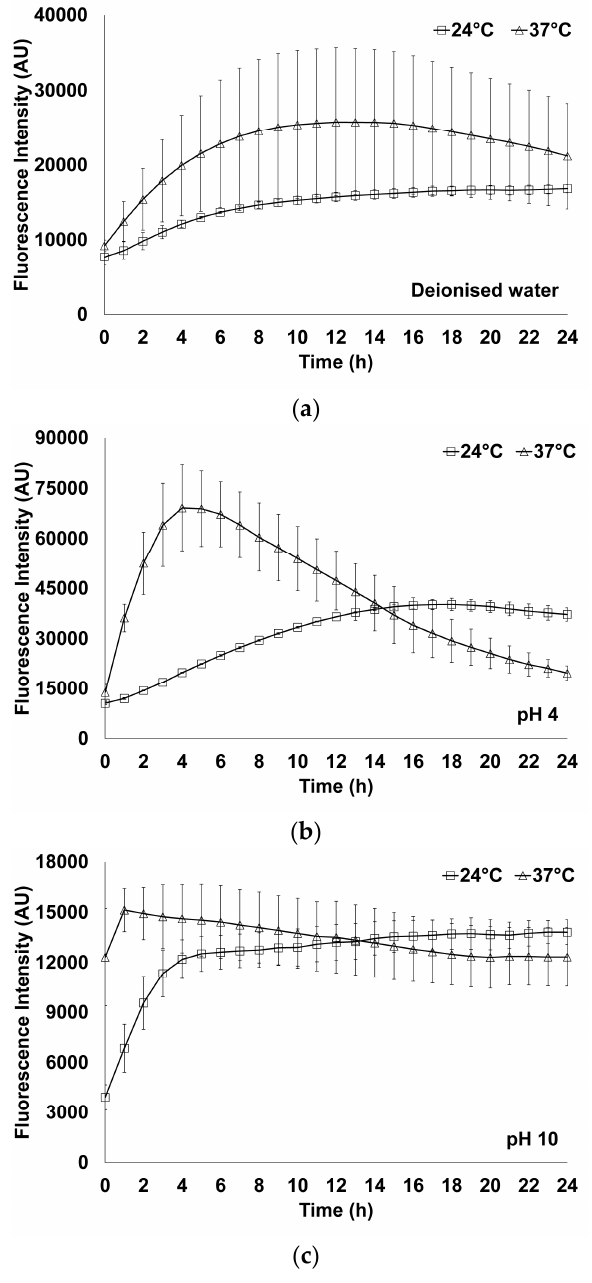
Figure 2. Fluorescence intensity of hydrogels during synthesis at 24 and 37 °C in ( a ) deionised water; ( b ) at pH 4; and ( c ) at pH 10.